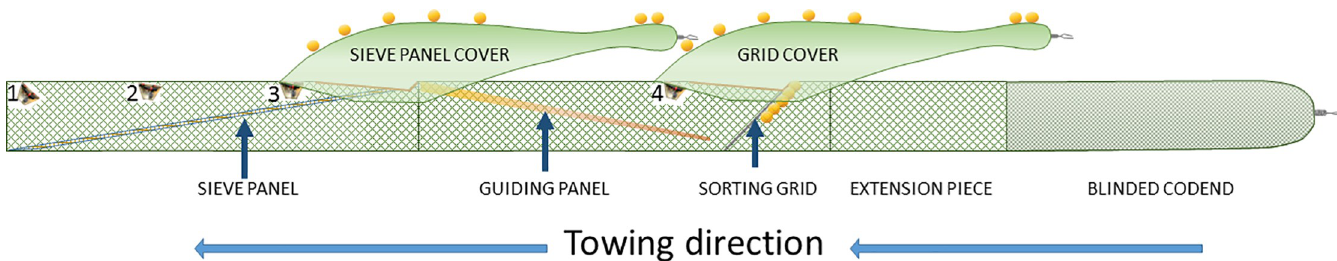
Fig 3. Illustration of the experimental gear design used during the trials (side view). The numbers 1, 2, 3 and 4 indicate the positions of underwater cameras during